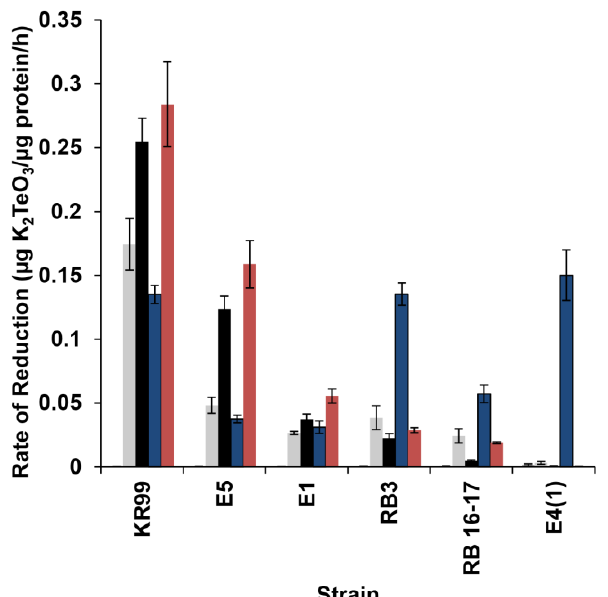
Figure 4. Rate of K 2 TeO 3 reduction in cellular fractions. ▀ Periplasm, ▀ Spheroplast, ▀ Spheroplast Lysate, ▀ Whole Cells, ▀ Membranes. Error bars represent one standard